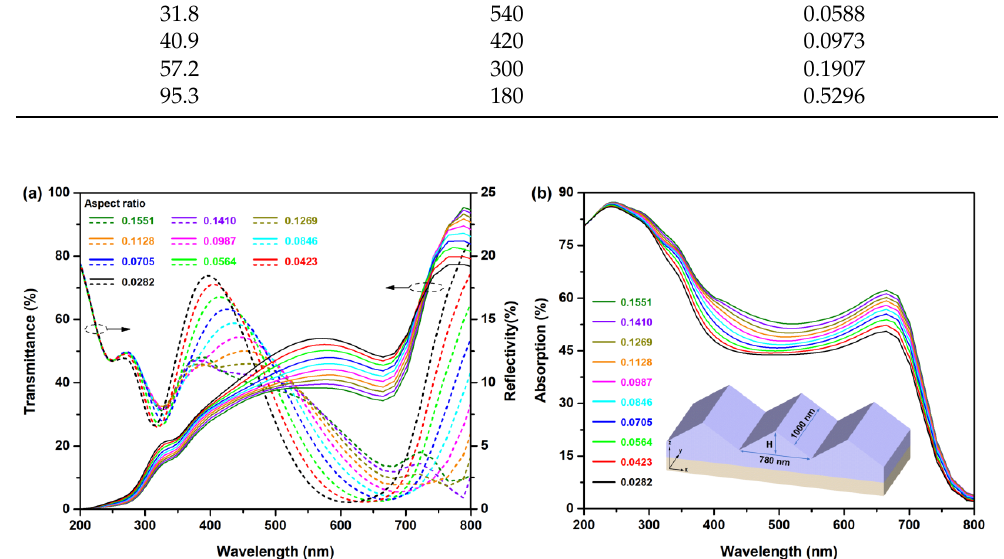
Figure 7. ( a ) Transmission and reflection spectra of the textured surface with different aspect ratios of the SANR structures and ( b ) corresponding absorption spectra. The inset demonstrates the structural parameters of the numerical model: the width was fixed at 780 nm and the height was changed, thus changing the aspect ratio.